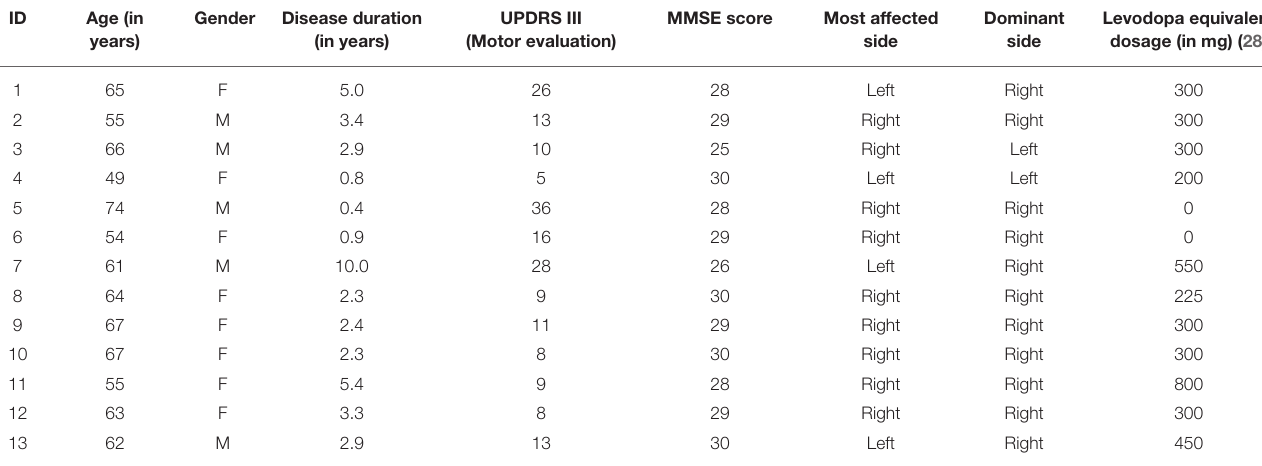
TABLE 1 | Research participant demographics and clinical characteristics.